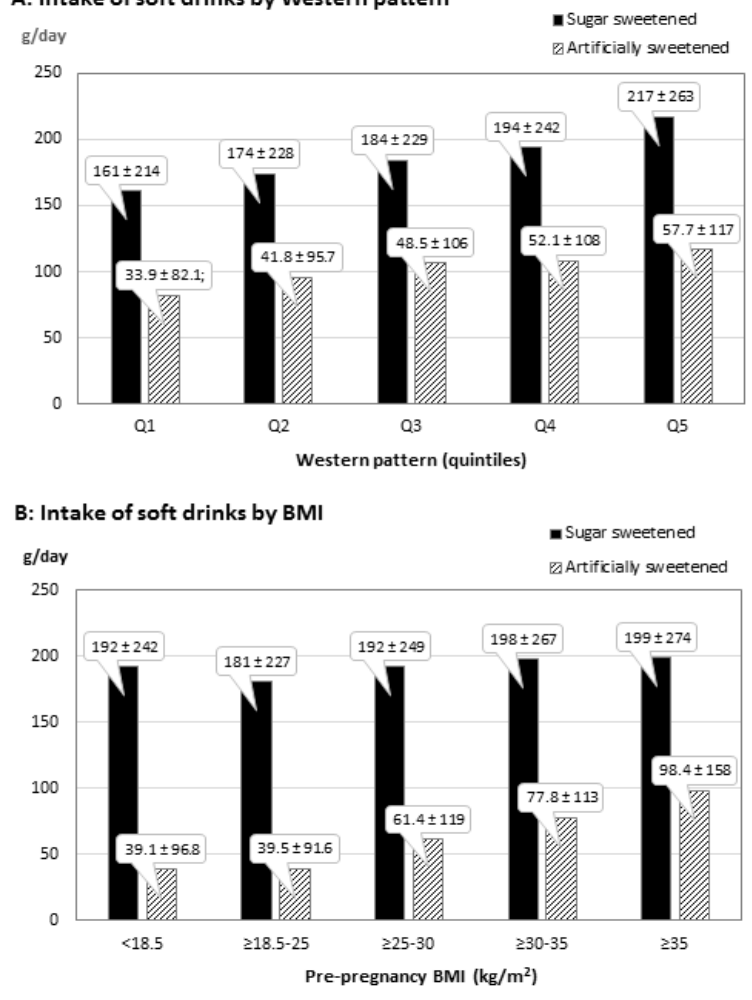
Figure 2. Maternal intakes in the Danish National Birth Cohort of sugar and artificially sweetened soft drinks (± SD) in mid-pregnancy ( n = 53.922) according to Western dietary pattern and pre-pregnancy